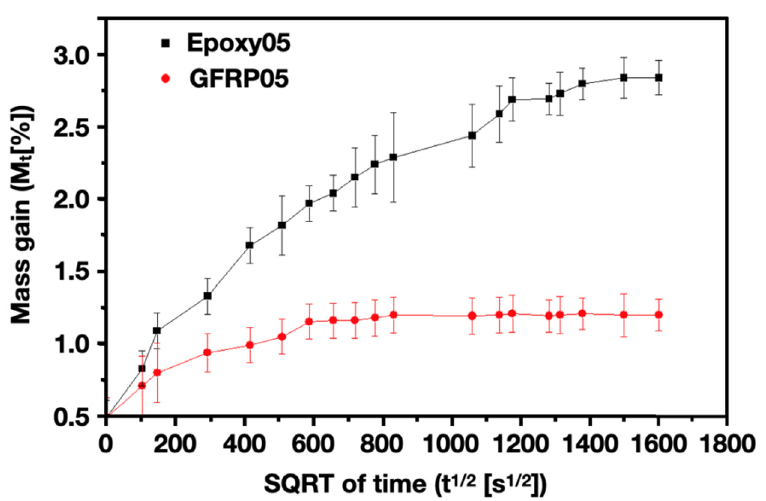
Figure 3. Gravimetric experiment results of Epoxy05 and GFRP05 samples full immersed into artificial salty water at 80 ◦ C. All samples were tested up to 712